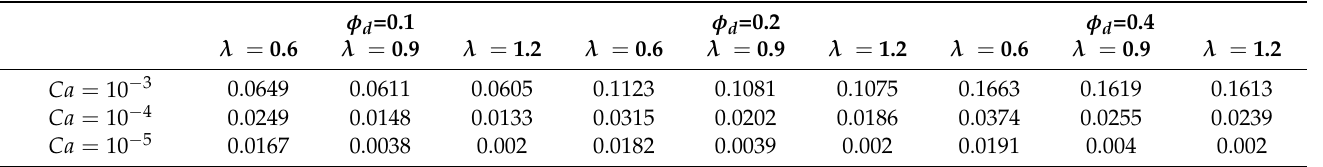
Table 1. K rdo endpoint values with different dimensionless